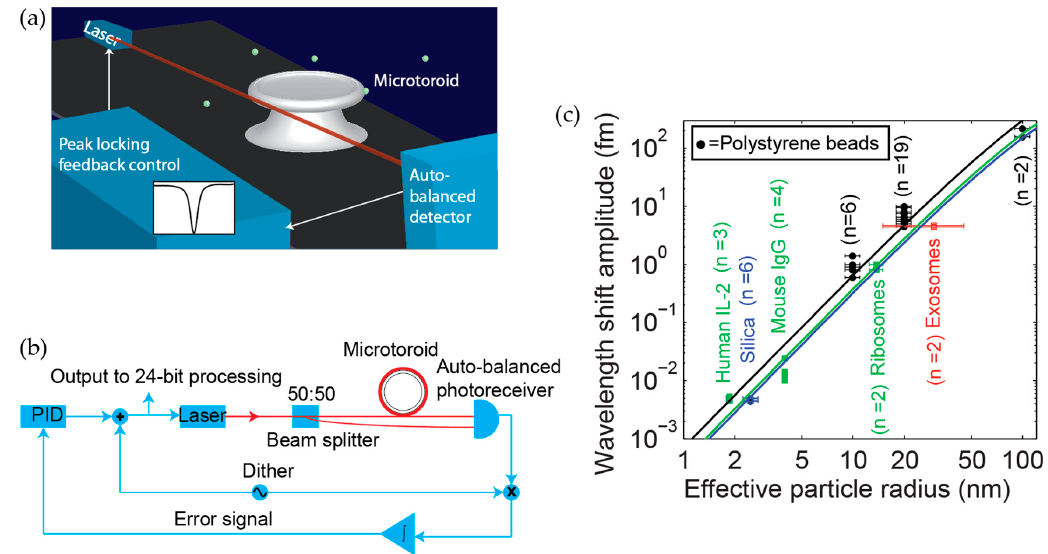
Figure 8. Overview of FLOWER and summary of particle detection data ( a ) FLOWER schematic. Frequency locking in combination with auto-balanced detection and data processing techniques have been used to improve the signal-to-noise ratio of microtoroid optical resonators to the extent that single macromolecule detection is possible. Reprinted (adapted) with permission from [16]. Copyright 2015 American Chemical Society; ( b ) Block diagram of FLOWER. Reproduced from [1]; and ( c ) Summary of particle detection data acquired using FLOWER. The different colored solid lines are theoretical predictions corresponding to different particle dielectric constants. Reproduced from [1].